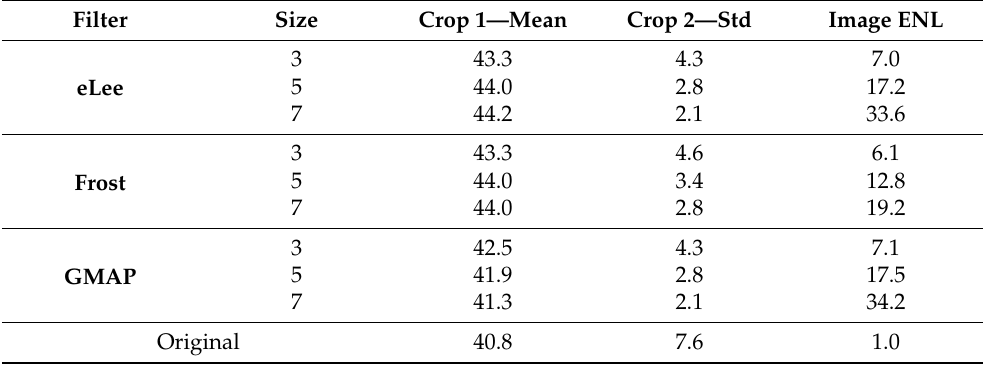
Table 1. Quantitative comparison of the applied filters. The mean, standard deviation (std), and Equivalent Number of Looks (ENL) are calculated in the linear